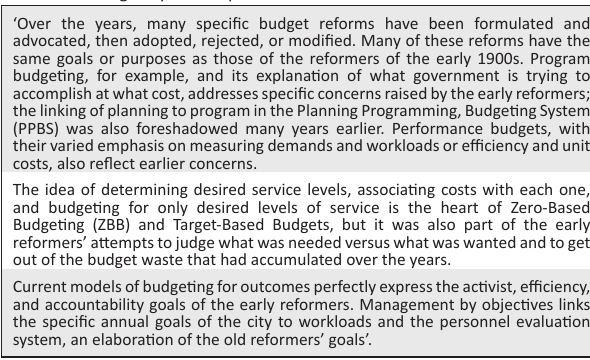
FIGURE 1: A world view of the budget